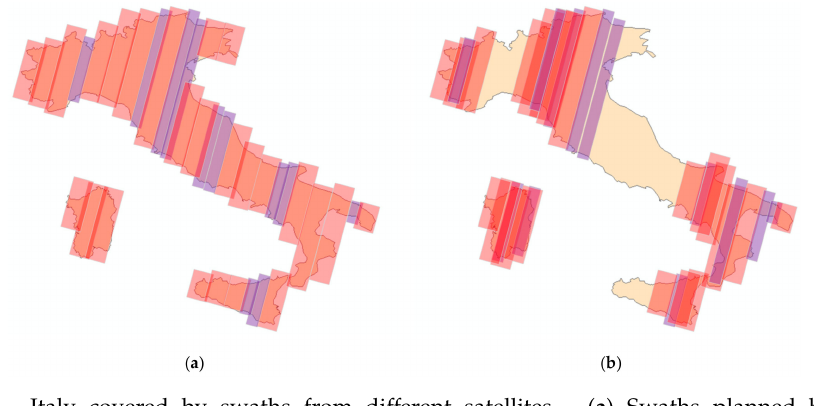
Figure 1. Italy covered by swaths from di ff erent satellites. ( a ) Swaths planned by using “maximal-coverage” criteria; ( b ) No planned